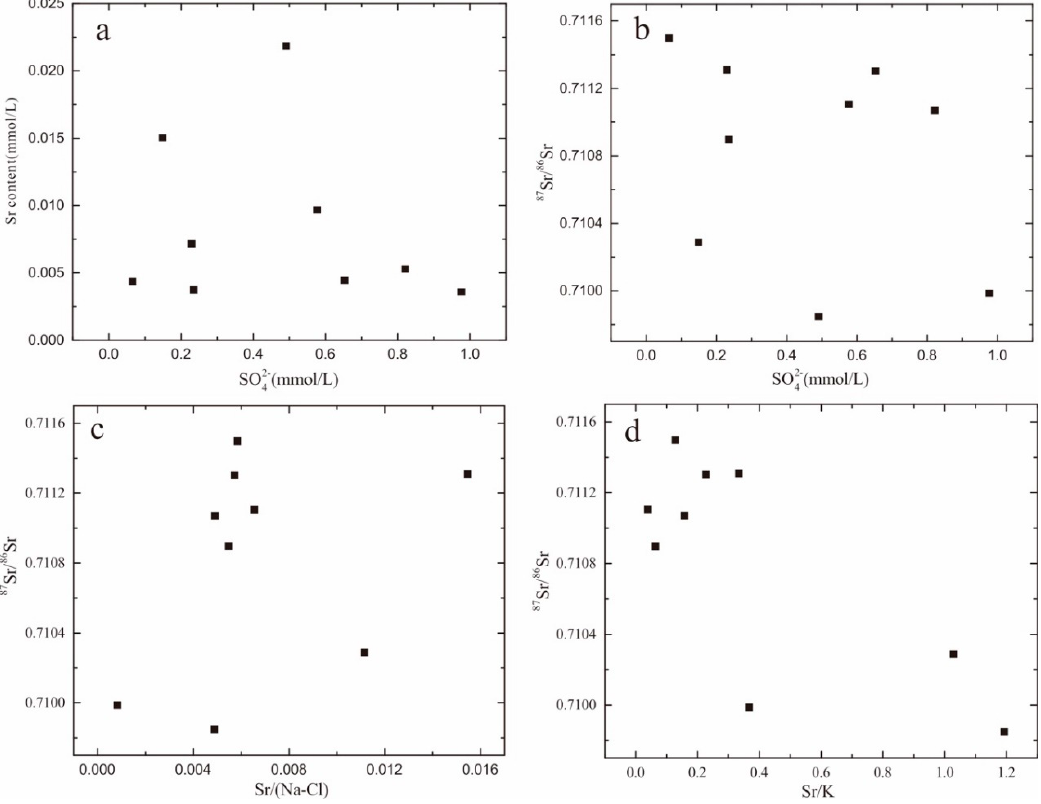
Figure 8. Relationships between Sr isotopes and molar ratios between Sr and other ions of groundwater ( a – d ).